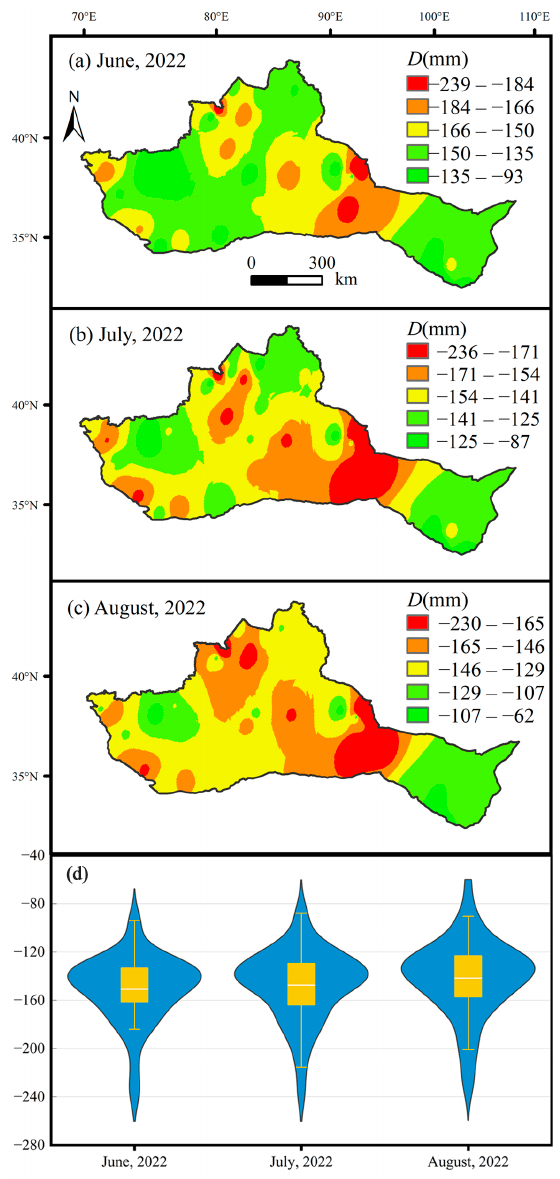
Figure 8. The forecasted monthly D for ( a ) June 2022, ( b ) July 2022, and ( c ) August 2022 based on the established RF models in northwestern China. ( d ) The violin chart describes the overall situation of D from June to August.